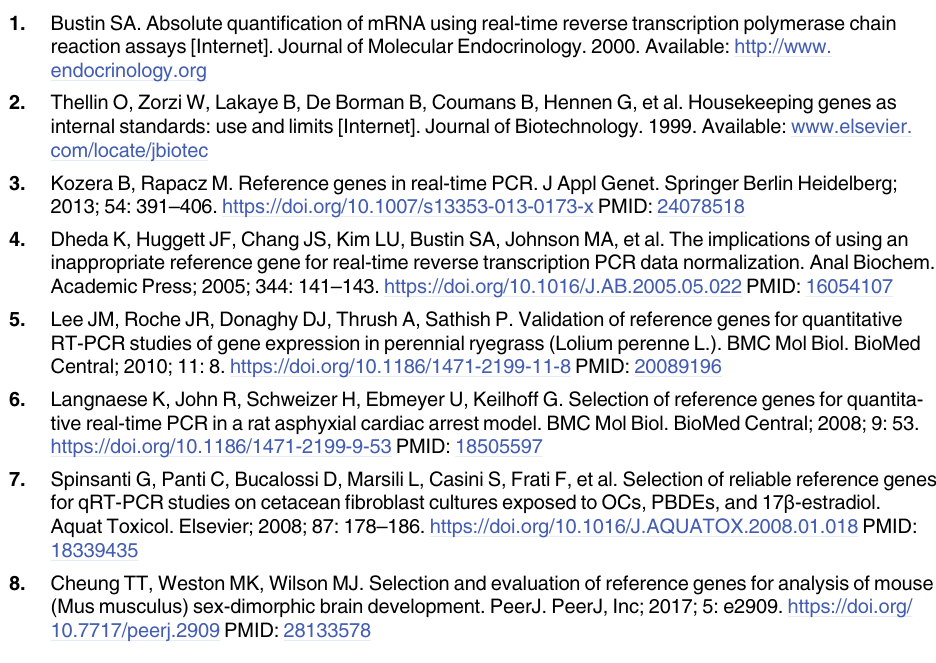
S4 Table. Pearson’s correlation matrix for the spinal cord. S5 Table. Raw qPCR output